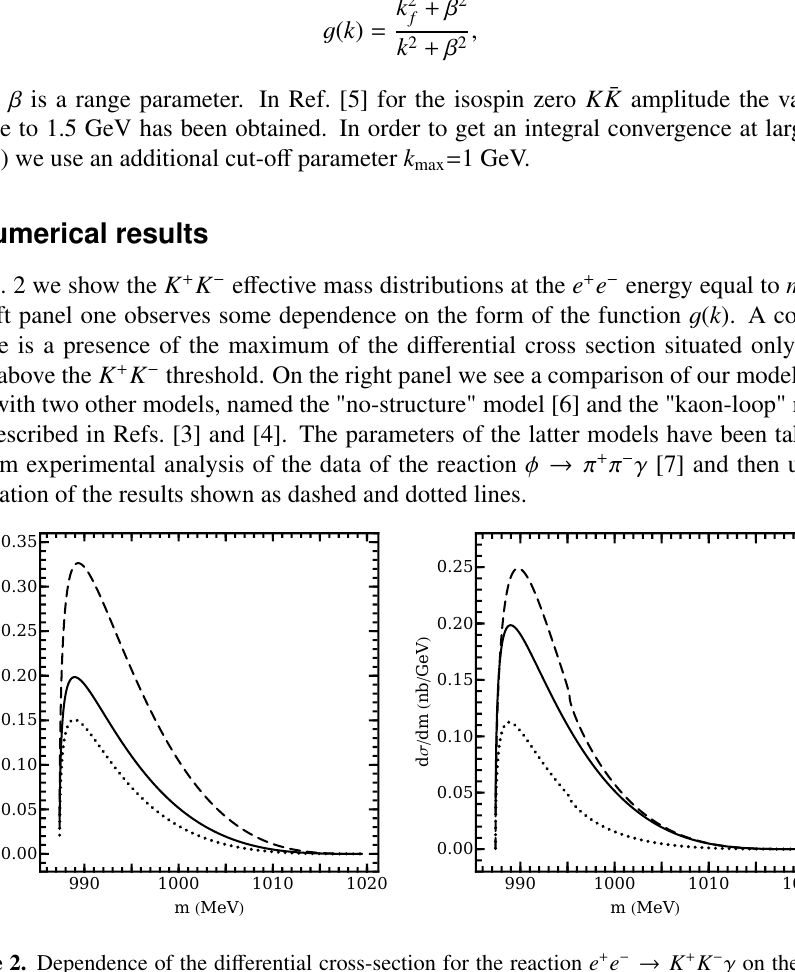
Figure 2. Dependence of the di ff erential cross-section for the reaction e + e − → K + K − γ on the K + K − e ff ective mass m . Left panel: the solid line corresponds to the case of the function g ( k ) (Eq. 12) with the parameter β ≈ 1 . 5 GeV and the cut-o ff k max = 1 GeV, the dotted line - to g ( k ) ≡ φ ( k ) given by Eq. (10) and the dashed curve - to g ( k ) from Eq. (11) with µ = 141 MeV; right panel: the dashed line is calculated for the no-structure model (Ref. [6]), the dotted one for the kaon-loop model of Ref. [4] with parameters obtained in Ref. [7] and the solid line is the same as in the left panel but with a di ff erent vertical